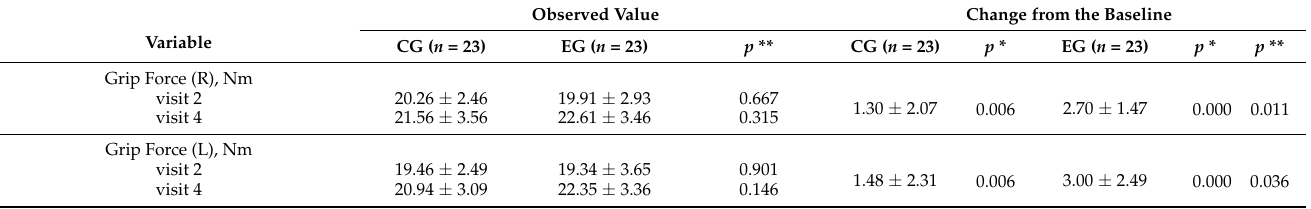
Table 5. Secondary outcome comparisons between and within each group (PP